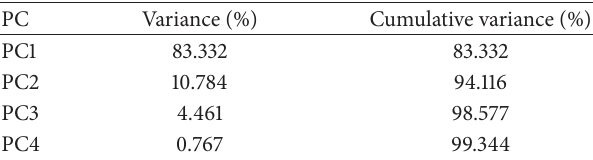
Table 4: Variance and cumulative variance for the first four PCs from PCA on the 16 moss species data subsets.